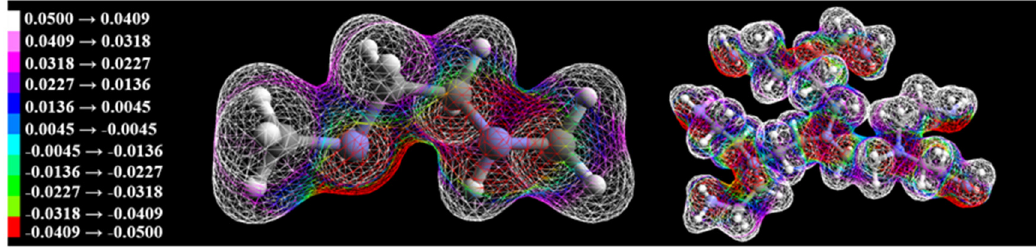
Figure 9. Calculated ESP density maps for linear ( left ) and branched ( right ) PEIs .